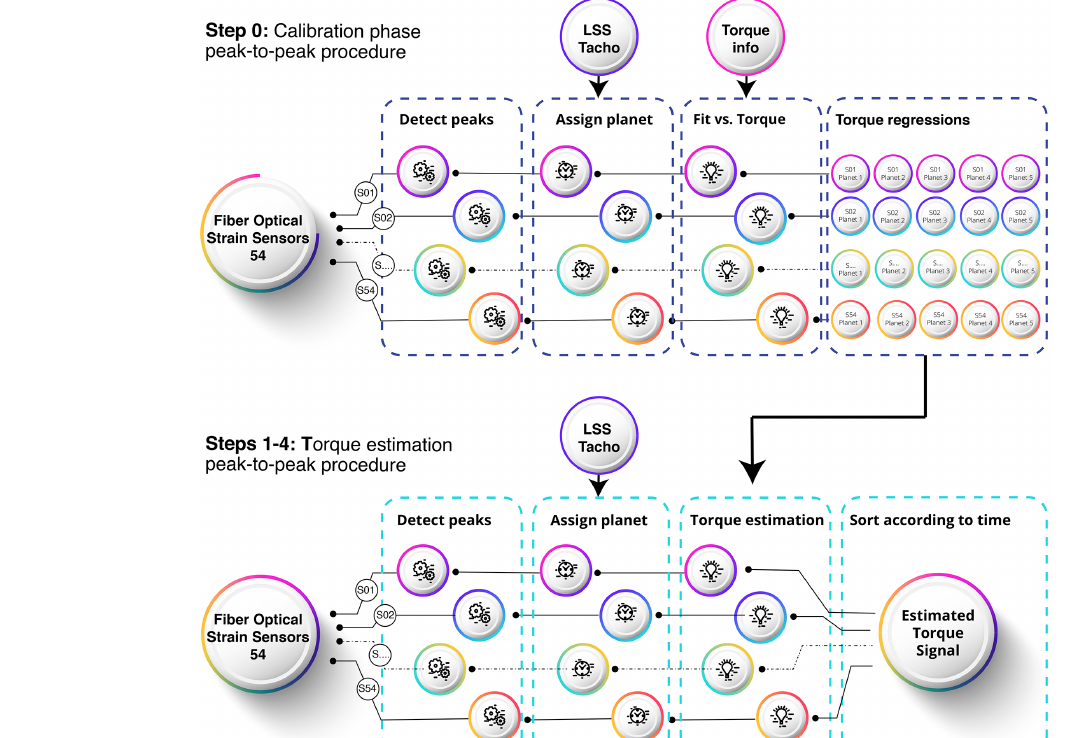
Figure 13. Torque estimation procedure based on peak-to-peak strain values.